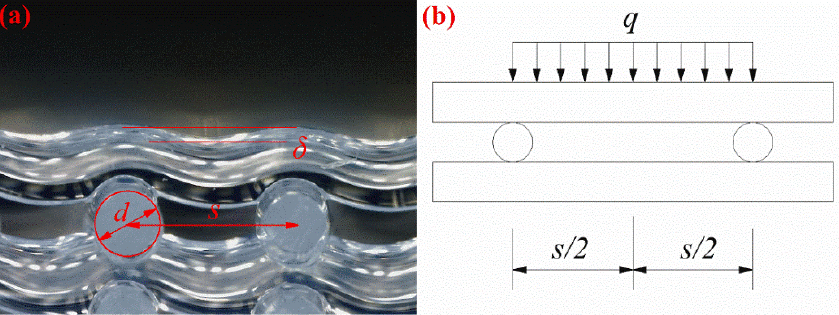
Figure 7. Structure of silicone foams: ( a ) schematic structural parameters of silicone rubber samples; ( b ) simplified mechanical model of filament stacking.